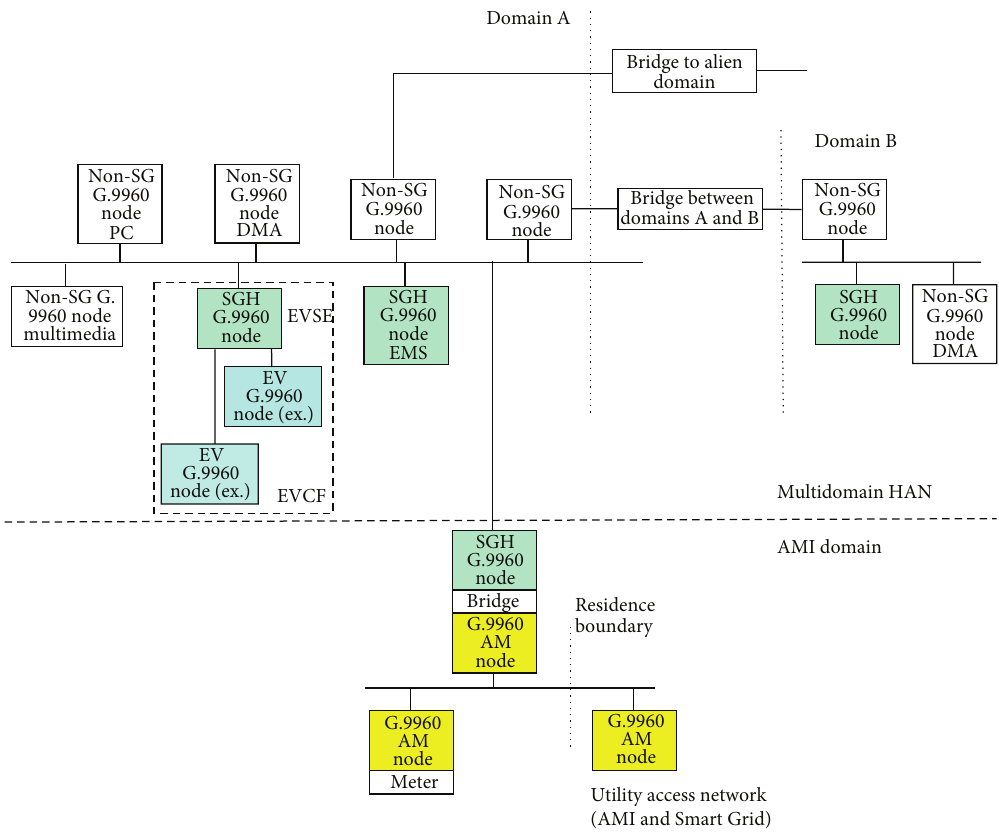
Figure 5: Smart Grid HAN implementation based on G.9960, based on Figure 22 in